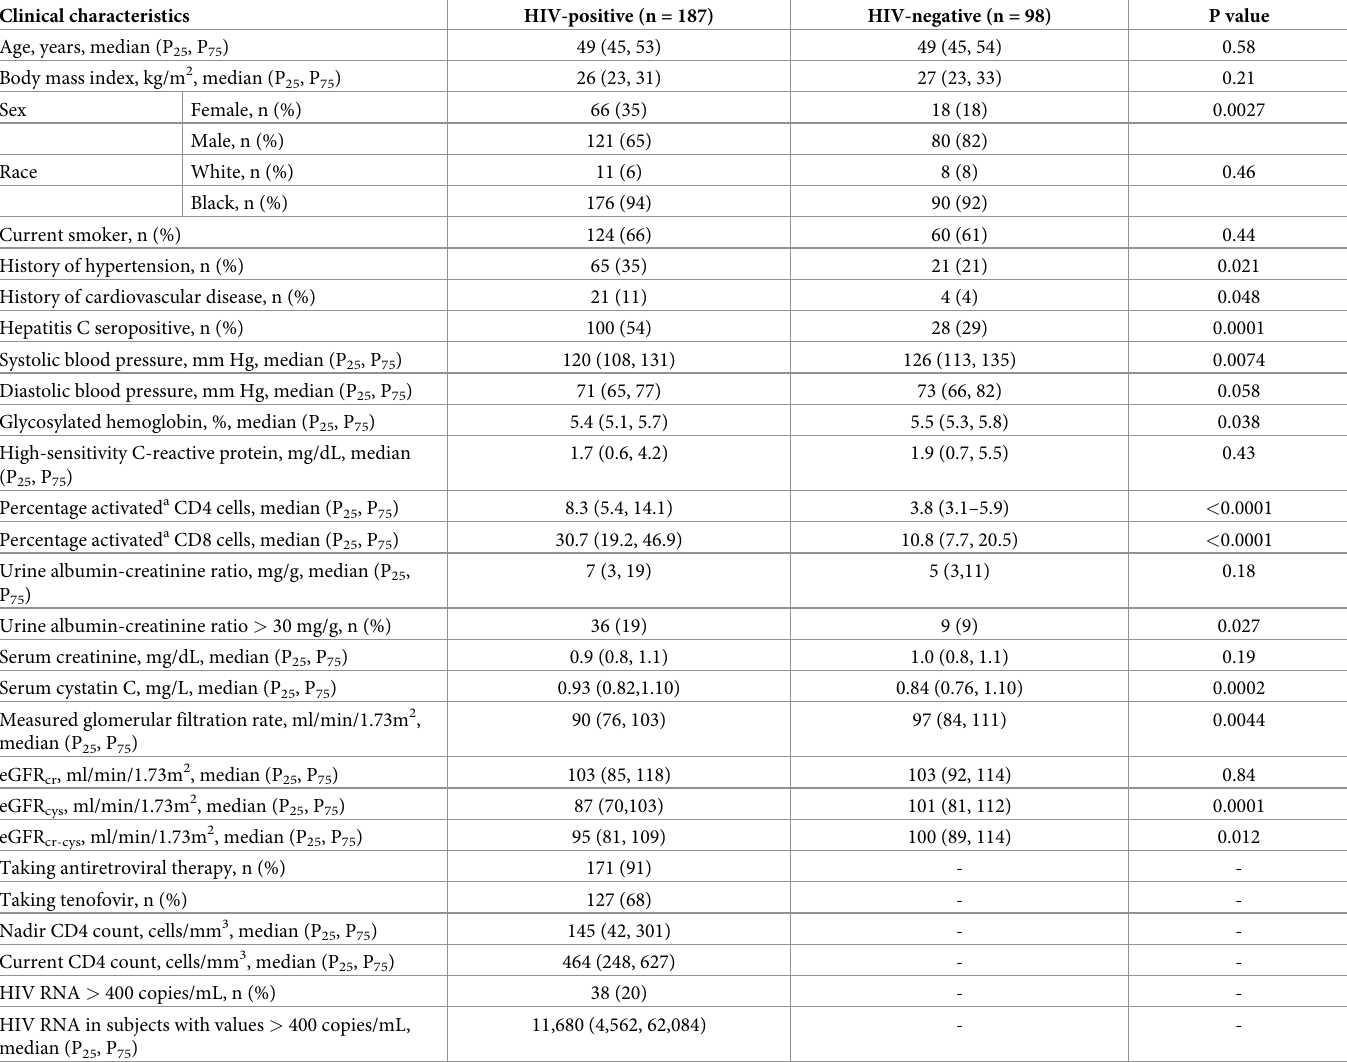
Table 1. Clinical characteristics of HIV-positive and HIV-negative